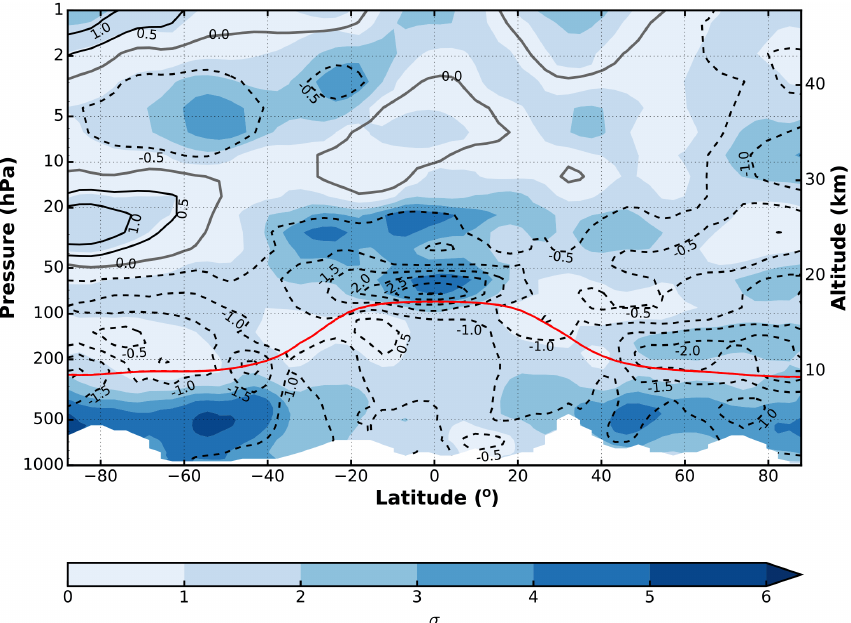
Figure 11. Ozone reduction due to VSLS. Medium-term full-chemistry future simulation with and without VSLS. Zonal mean profile of decadal mean difference in percent ( ( RT1a − RT1b )/ RT1a × 100). Dashed lines indicate a decrease of ozone in the simulation with VSLS turned on (RT1a) compared to the one with VSLS turned off (RT1b). The average tropopause is shown as red line. Significance is indicated by blue shaded areas. The significance is estimated as manifold of difference from zero in units of standard error of mean